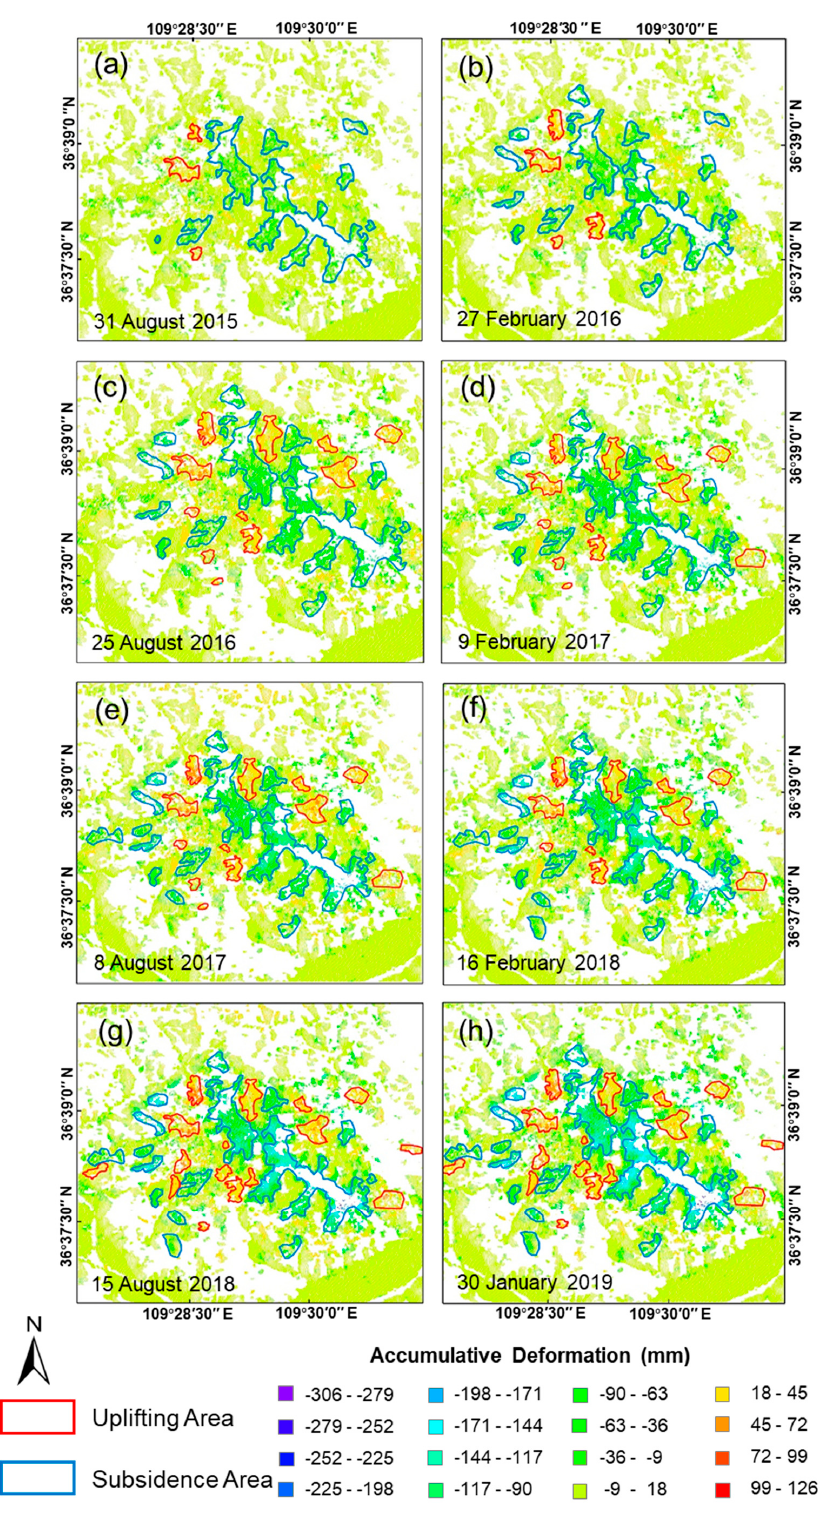
Figure 8. ( a – h ) Evolution of land deformation in YND from February 2015 to January 2019. Red and blue polygons represent uplift and subsidence areas, respectively. Moreover, the color scale represents the cumulative deformation relative to February 2015.